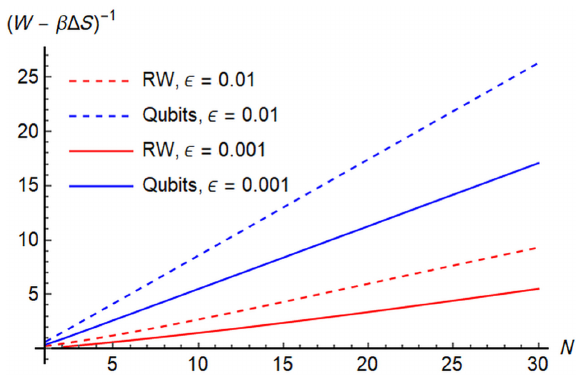
FIG. 3. Imperfect cooling. We compare the cooling perfor- mance of a degenerate qubit target system using either N machine qubits of linearly increasing energy accessed sequen- tially or a single unitary on a 2 N -dimensional machine, the latter being a finite adaptation of a protocol presented in Ref. [29]. We set β = 1, choose units such that (cid:3) = k B = 1, and fix 1 − (cid:7) to be the desired final ground-state population of the target. We plot the inverse of the excess work cost above the Landauer limit, W − β (cid:4) (cid:5) S S (in units of the smallest machine energy gap, ω min confirming that the surplus work cost in both cases scales with N − 1 . Interestingly, we see that the protocol in which the target is sequentially swapped with machine qubits outperforms